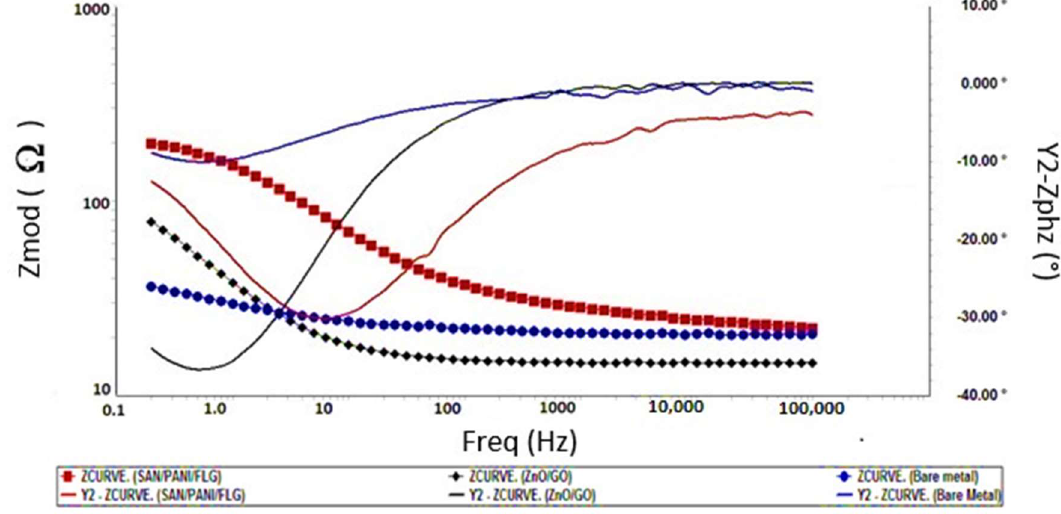
Figure 2. Bode Plots-bare and coated samples in seawater.